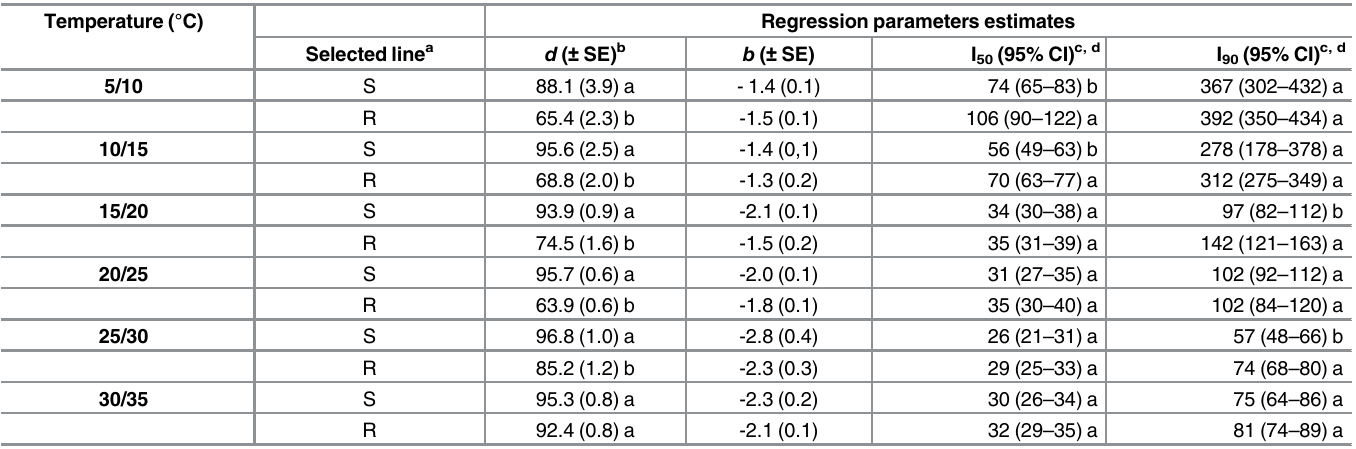
Table 2. Regression parameters estimated from the three-parameter log-logistic model (Eq 1: d = upper limit, b = slope) for percent cumulative ger- mination of dicamba-fluroxypyr – susceptible (S) and – resistant (R) K . scoparia at various alternating (12/12 h cycle) temperatures averaged over experimental